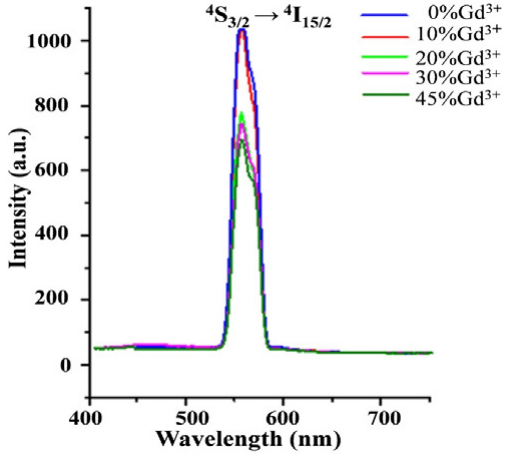
Fig. 7 Emission spectra for 20%Yb 3+ /2%Er 3+ doped NaLuF 4 nanocrystals with different Gd 3+ contents monitored at λ